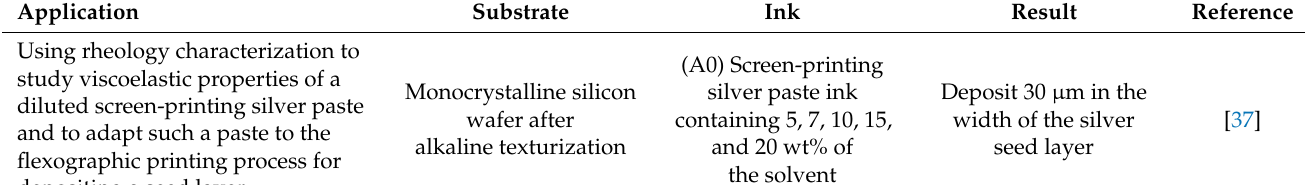
Table 1. Summary of flexographic printing technique on silicon solar